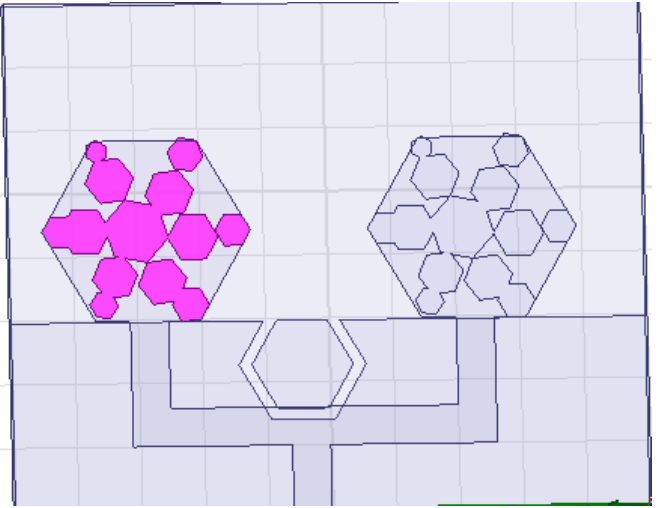
Figure 8. Proposed hexagonal fractal antenna array (HFAA) second iteration with defected ground (hexagonal-shaped).